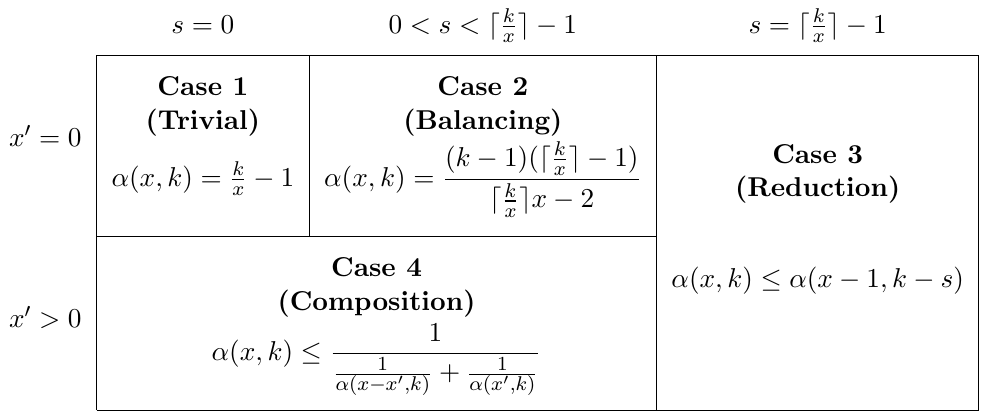
Table 1: Values of and upper bounds on α ( x, k ) , depending on the values of s ≡ k (mod d k (cid:6) (cid:7) and x 0 = x − k/ d k e . x For all four cases we start by forming d k/ d k/x ee normalised colour classes, each comprising d k/x e full partite sets, except possibly for the last utilised colour class, which comprises s ≡ k (mod d k/x e ) full partite sets if x | /k (in the case where x | k , all colour classes comprise the same number of partite sets). Upon completion of this partition of the partite sets, x 0 = x − d k/ d k/x ee colours remain unutilised. The values of s and x 0 are used as decision variables to distinguish between the cases in Table 1 in our recursive normalised ∆( ˜ d, x ) k –partite colouring strategy given in pseudo–code as Algorithm α ( x, k ), which outputs an upper bound α ( x, k ) on α ( x, k